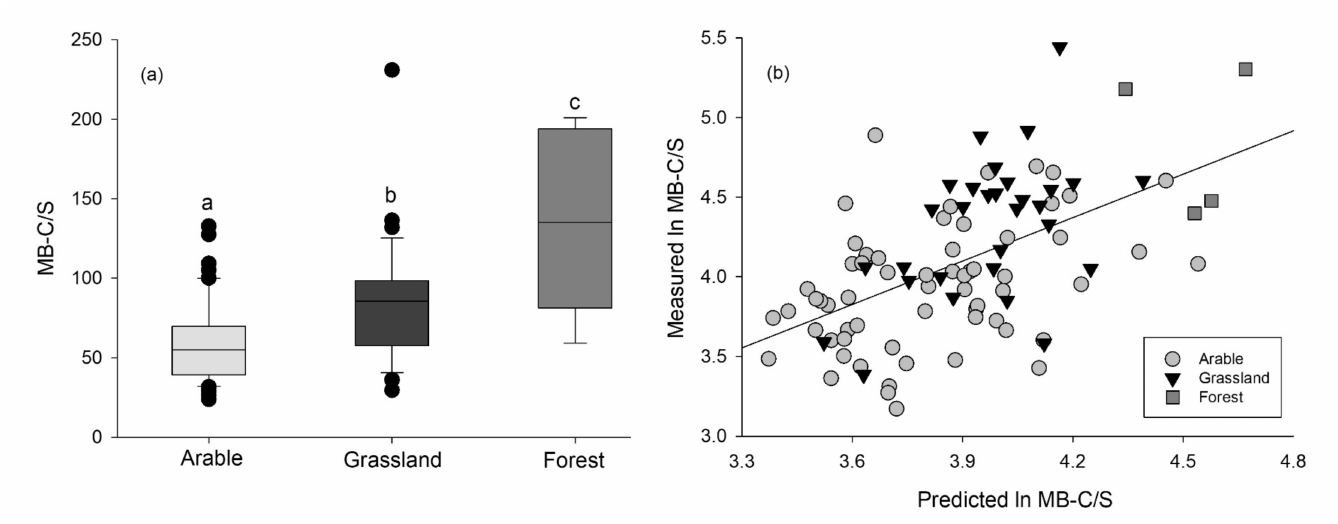
Figure 4. ( a ) MB-CS ratios in arable ( n = 67), grassland ( n = 33), and forest soils ( n = 7), different letters on top of outliers or whisker caps indicate a significant difference ( p < 0.05, Holm–Sidak test); ( b ) multiple linear relationship between the MB-C/S ratio as a dependent variable and the SOS content as well as soil pH in water as independent variables: ln MB-CS = 4.802 *** + 0.138 * × ln SOS − 0.232 *** × pH-H 2 O, n = 97, adjusted r 2 = 0.33 ***; * p < 0.5, *** p <